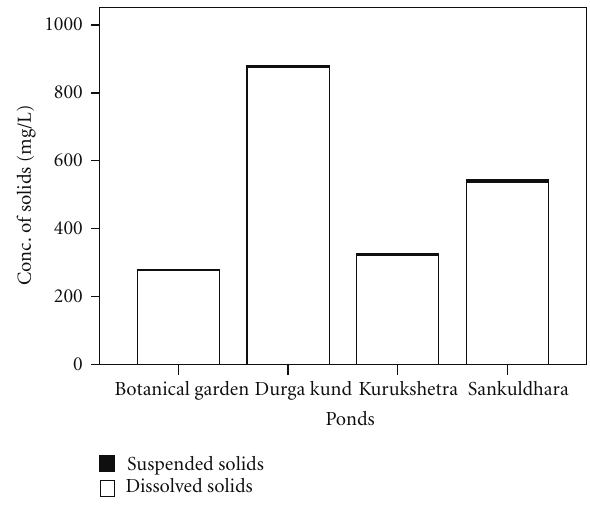
Figure 1: Concentration (mg/L) of total solids, suspended solids and dissolved solids in the control (Botanical garden) and anthro- pogenically stressed (Kurukshetra, Sankuldhara and Durgakund)